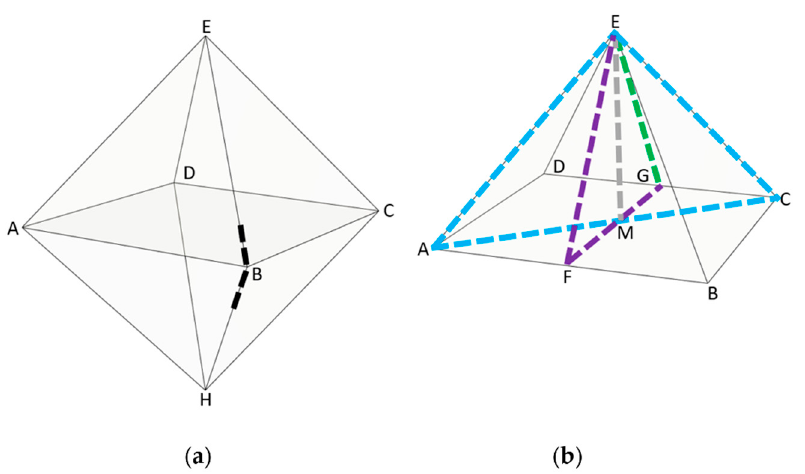
Figure 4. ( a ) Octahedron as formed by {111} planes in Si. The angle indicated by the black dotted line is, by definition, 90°. ( b ) A pyramid cut from an octahedron. The coloured lines indicate different cross-sections of the pyramid.